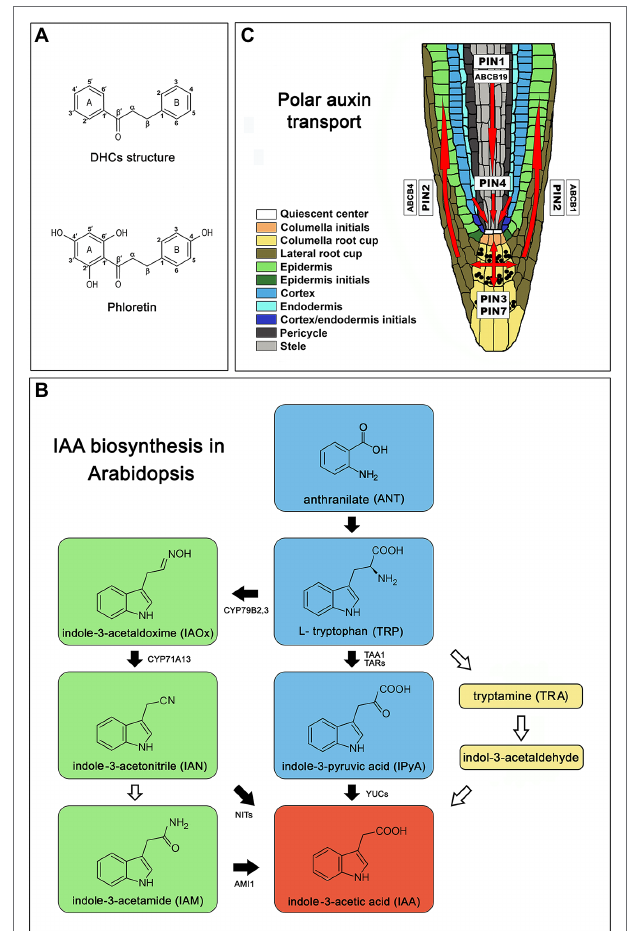
FIGURE 1 | Introductory picture. (A) Chemical structure of dihydrochalcones (DHCs) and phloretin. (B) Schematic representation of IAA biosynthesis in Arabidopsis [ Arabidopsis thaliana (L.) Heynh.] Col-0 based on a review of Brumos et al. (2014). Green color represents pathway specific to the genus Brassica (Sugawara et al., 2009). Black arrows indicate well characterized steps. White arrows mark poorly understood steps or incomplete pathways. (C) Polar auxin transport in Arabidopsis root based on Vieten et al. (2005), Michniewicz et al. (2007) and Geisler et al. (2017); red arrows indicate directions of auxin flow. AMI1 (indole-3-acetamide hydrolase), ABCB (ATP- binding cassette-B), CYP71A13 (indole-acetaldoxime dehydratase CYP71A13), CYP79B2,3 (cytochrome P450 monooxygenases CYP79B2 and CYP79B3), PIN (pin-formed), NITs (nitrilases), TAA1 (tryptophan aminotransferase of Arabidopsis 1), TAR2 (tryptophan aminotransferase related 2), YUC (flavin-binding